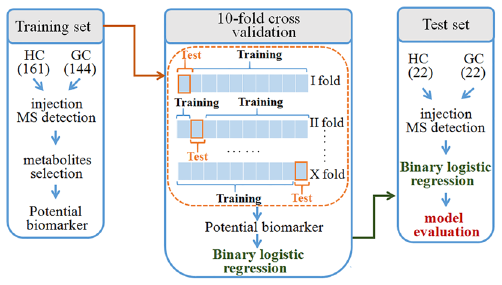
Figure 1. Design of the study. GC, gastric cancer; HC, healthy